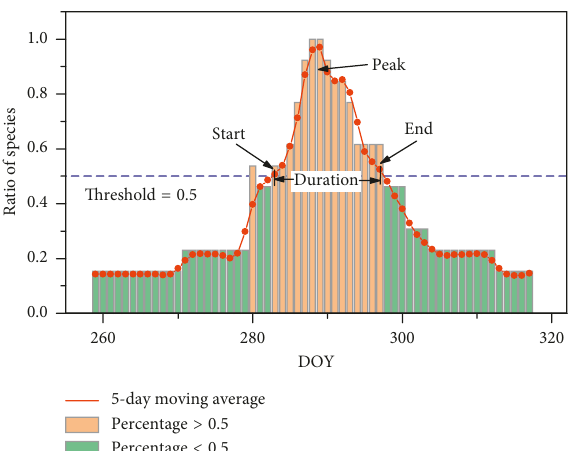
Figure 3: Schematic diagram for determining the leaf coloring season (LCS) metrics. Because large fluctuations (e.g., DOY280) may influence the determination of the LCS, we use a 5-day moving average (red line) to smooth the daily numbers of species in